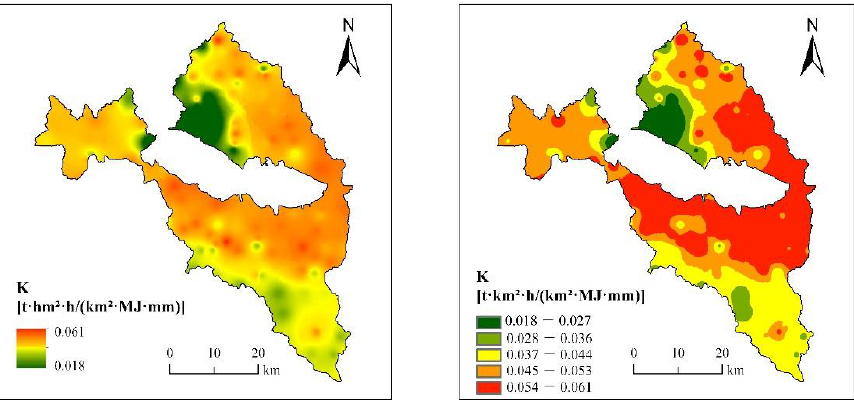
Figure 3. Spatial distribution of soil erodibility factor K in the South and North Mountains of Lan- zhou. of